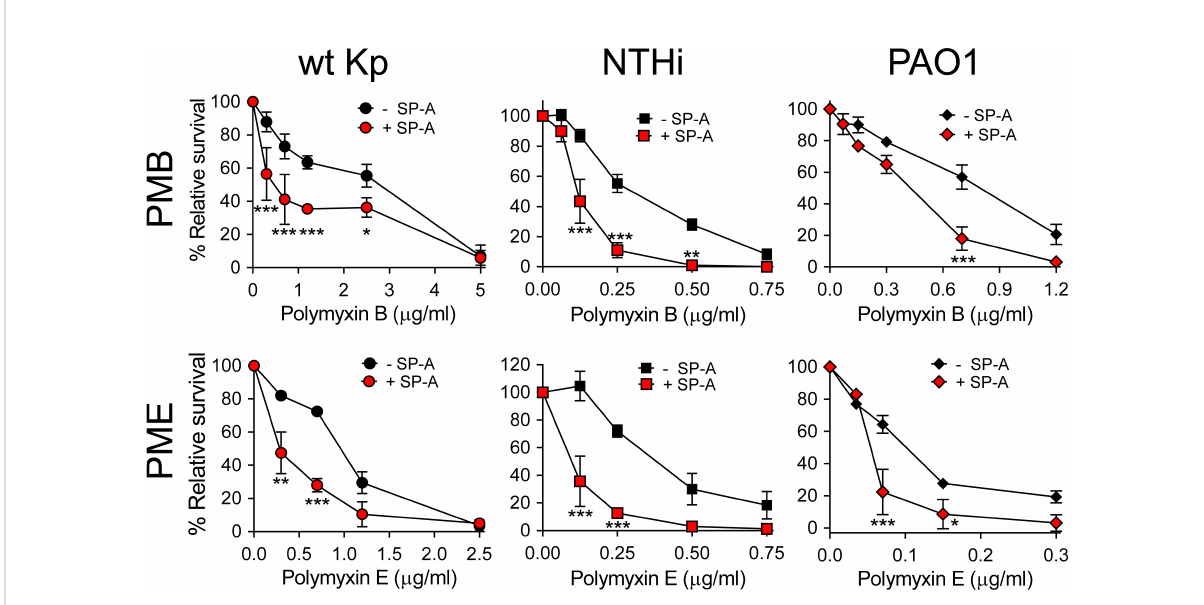
FIGURE 6 SP-A acts synergistically with polymyxin B and colistin (PME) against Gram-negative bacteria. 10 5 CFUs/ml of bacteria ( K. pneumoniae , NTHi, and P. aeruginosa O1) were incubated with different concentrations of PMB (upper graphs) and PME (lower graphs) in the absence or presence of SP-A (100 m g/ml) in 10 mM phosphate, 1% TSB, and 100 mM NaCl buffer (pH 7.4) for 1 h at 37°C. Bacteria were then plated on LB agar ( Kp and PAO1) or sBHI agar (NTHi) for CFU counting. Results are shown as a percentage of relative survival compared to untreated bacteria. Data are means ± SD of four independent experiments, with three biological replicates. Results were statistically analyzed by one-way ANOVA followed by the Bonferroni multiple-comparison test. * p < 0.05, ** p < 0.01, and *** p < 0.001 when comparing SP-A-treated with SP-A- untreated K. pneumoniae